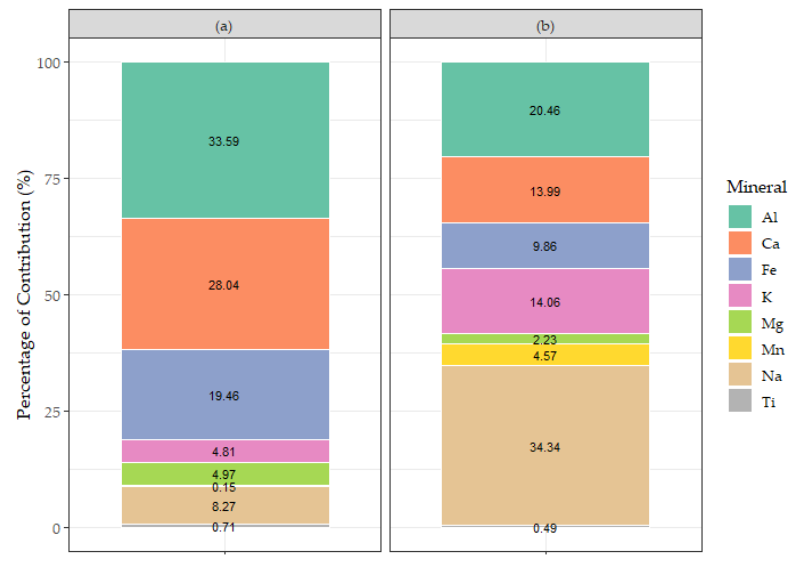
Figure 6. Average composition of main elements for: ( a ) Bogotá and ( b ) Manizales.